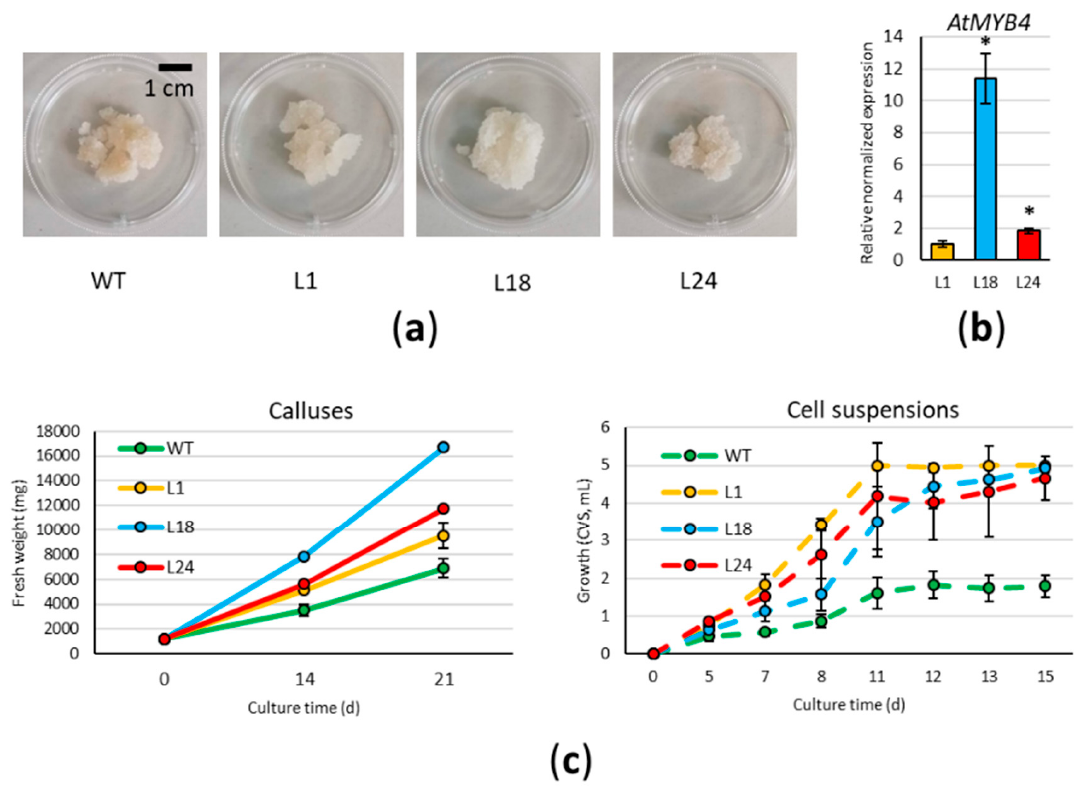
Figure 1. Phenotype and growth of cardoon lines: ( a ) Calluses of wild type (WT) and AtMYBoe lines (L1, L18, L24) grown for 21 days on solid medium; ( b ) Relative expression level (mean ± standard deviation, S.D.) of the transgene in the three lines selected for this study. Asterisks indicate significant differences ( p < 0.01); ( c ) Growth curves for calluses grown on solid medium (left) and for cell suspension grown in liquid medium (right). CVS: cell volume after sedimentation. Each value represents the mean of three biological replicates ±